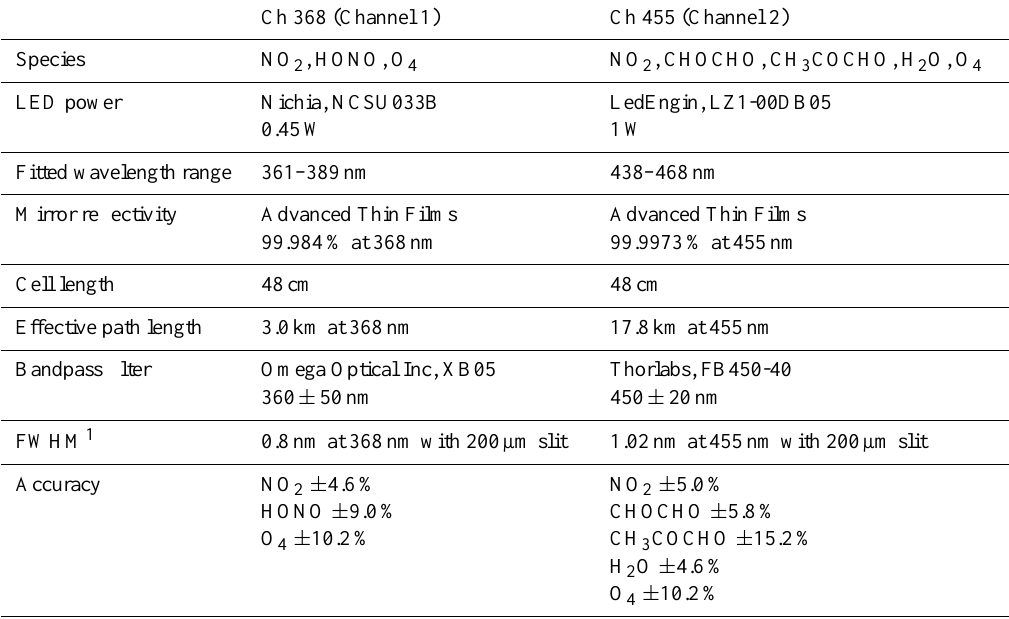
Table 1. ACES instrumental details and measurement accuracy